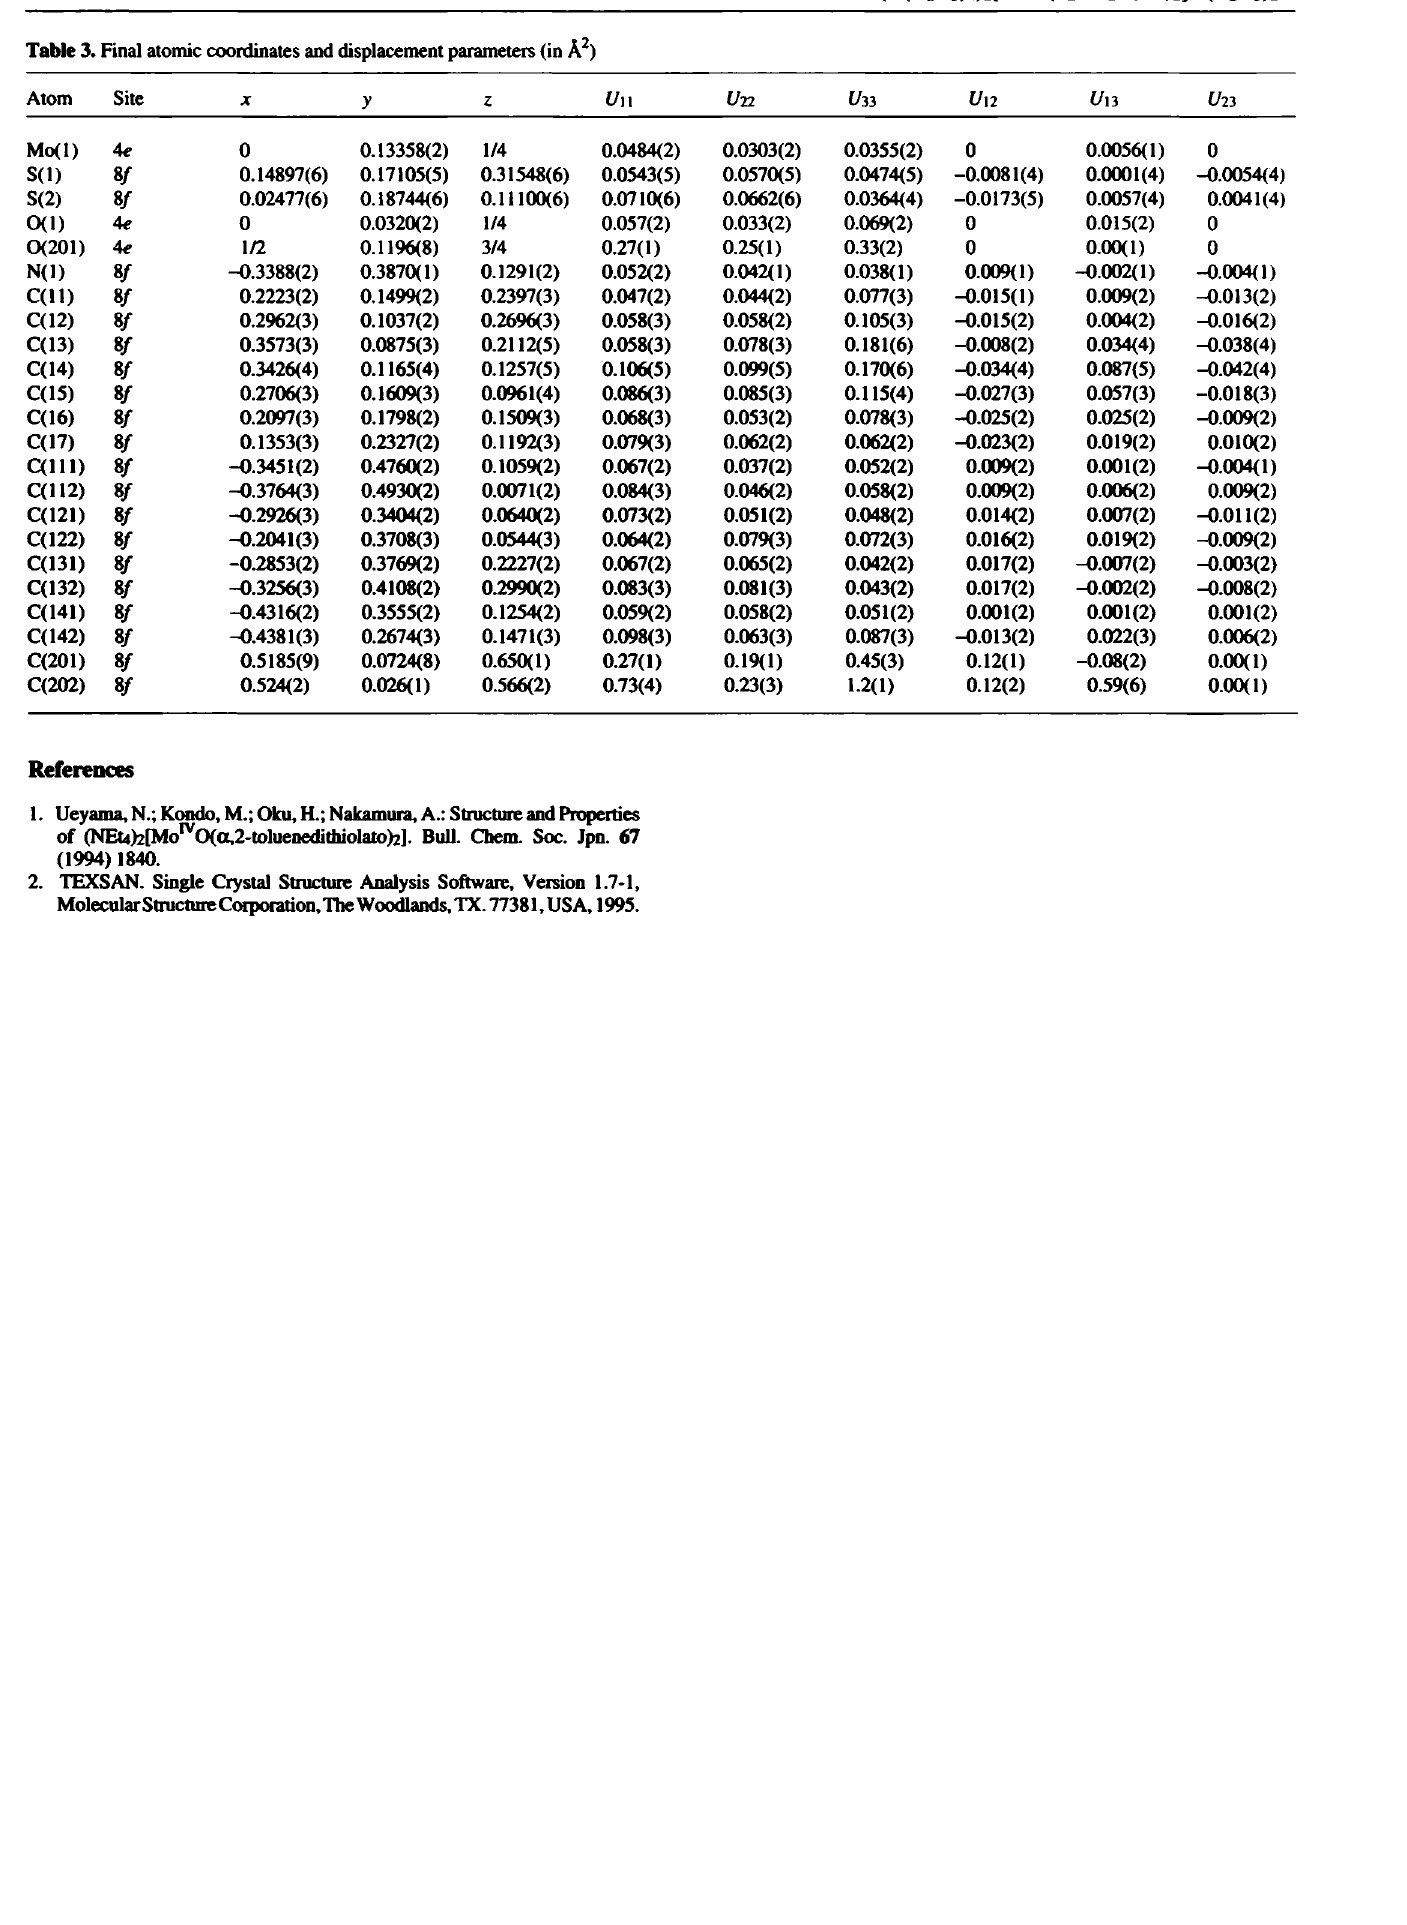
Table 3. Final atomic coordinates and displacement parameters (in À 2